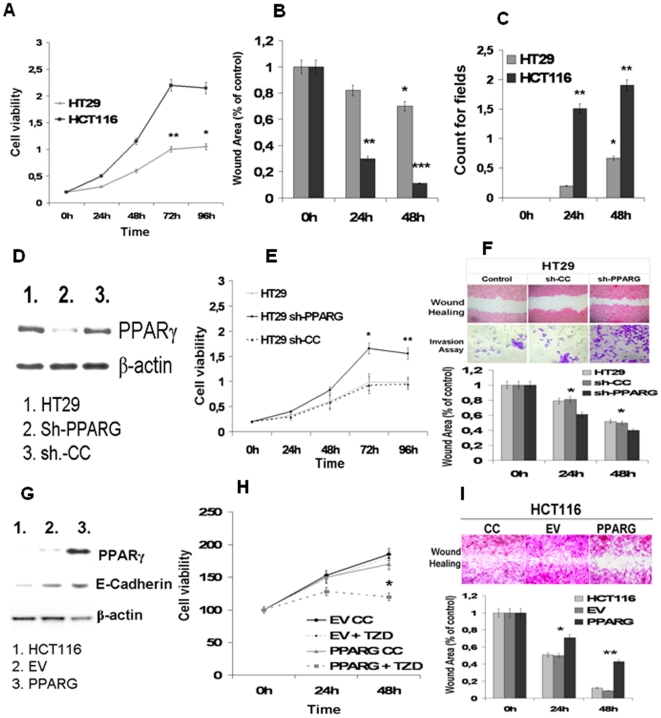

PPARG silencing increases proliferation and migration/invasiveness of CRC cells.(A) MTT assays on HCT116 and HT29 cells were carried out at different time-points *P = 0.004; **P = 0.001. (B) A wound-healing migration assay was carried out comparing and measuring the “wound area” at 24 and 48 hs *P = 0.045; **P = 0.0051; ***P = 0.0001. (C) Transwell migration assay was performed counting the run-through cells in 10 microscopic fields *P = 0.024; **P<0.01. The symbols represent the mean values of three independent experiments (mean ± SD). (D) Specific PPARG- or scrambled-shRNAs were stably transfected into HT29 cells to generate the shPPARG or control clones, respectively; the extent of PPARγ knock-down was documented by Western blot and referred to β-actin. (E) shPPARG cells showed higher proliferation than control clones and parental cells *P = 0.022; **P = 0.012. (F) The wound-healing migration and transwell migration assays were performed on the HT29 parental, the shPPARG and the control clone, respectively. The measurements were done as above. In both cases, cells were fixed after 48 hs and stained with hematoxylin & eosin or crystal violet, respectively. Magnification: 100×. Quantification of the wound-area after 24 and 48 hs is reported in the histogram where the control was set at 100%, *P = 0.016, **P = 0.001. Bars represent mean values ± SD of three independent experiments. (G) HCT116 cells were stably transfected with an empty expression vector or a vector carrying the PPARγ cDNA to generate control or the HCT116-PPARγ clones, respectively. Western blot analysis of the transfected PPARγ and activated target E-cadherin referred to β-actin. (H) The HCT116-PPARγ cells showed lower proliferation than control clones and parental cells in the presence of TZD *P = 0.012. (I) The wound-healing migration assay in HCT116 parental, the HCT116-PPARγ and the control clone. Cells were fixed after 48 hs and stained with hematoxylin & eosin. Magnification: 100×. The histogram shows quantification of the wound-area, measured as above, with the control set at 100%. Bars represent mean values ± SD of three independent experiments *P<0.05; **P<0.01.